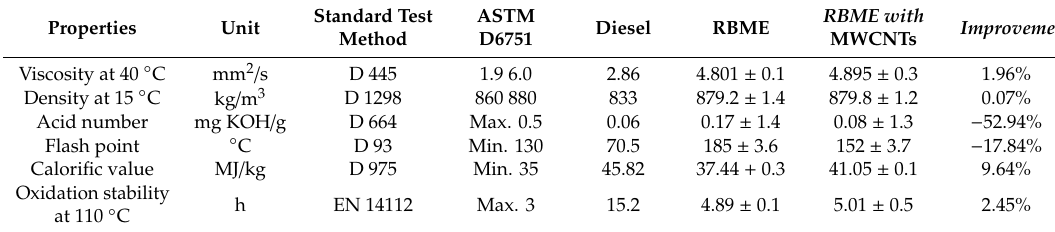
Table 7. Physical and chemical properties of the pure rice bran methyl ester (RBME) and RBME with multi-walled carbon nanotubes